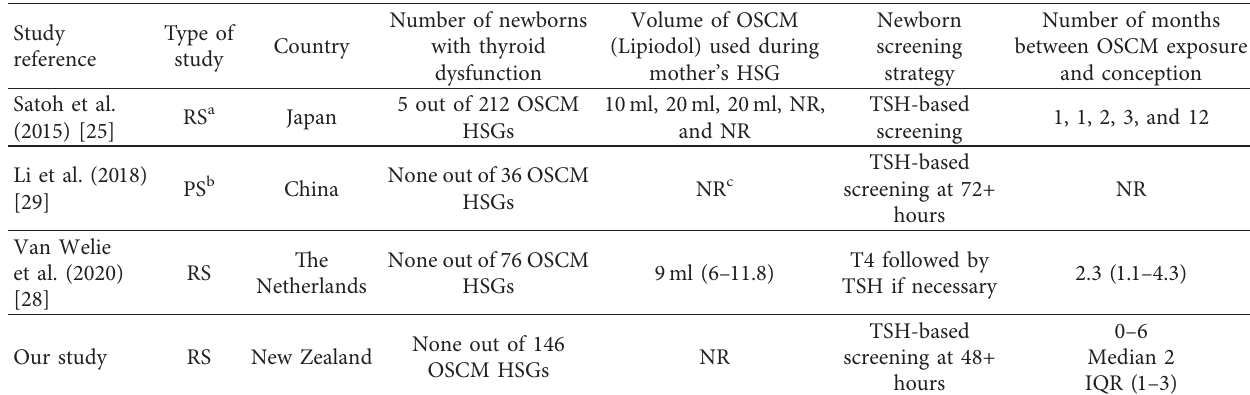
Table 4: Comparison of our study with previous studies assessing the effect of OSCM HSG on the newborn’s thyroid.